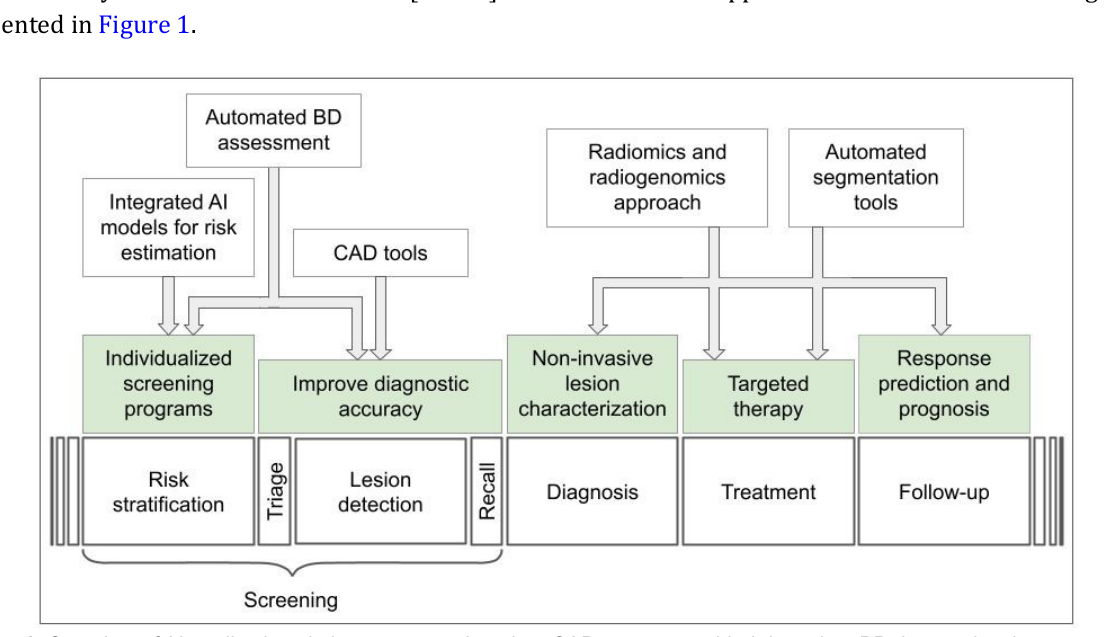
Figure 1. Overview of AI applications in breast cancer imaging. CAD: computer-aided detection; BD: breast